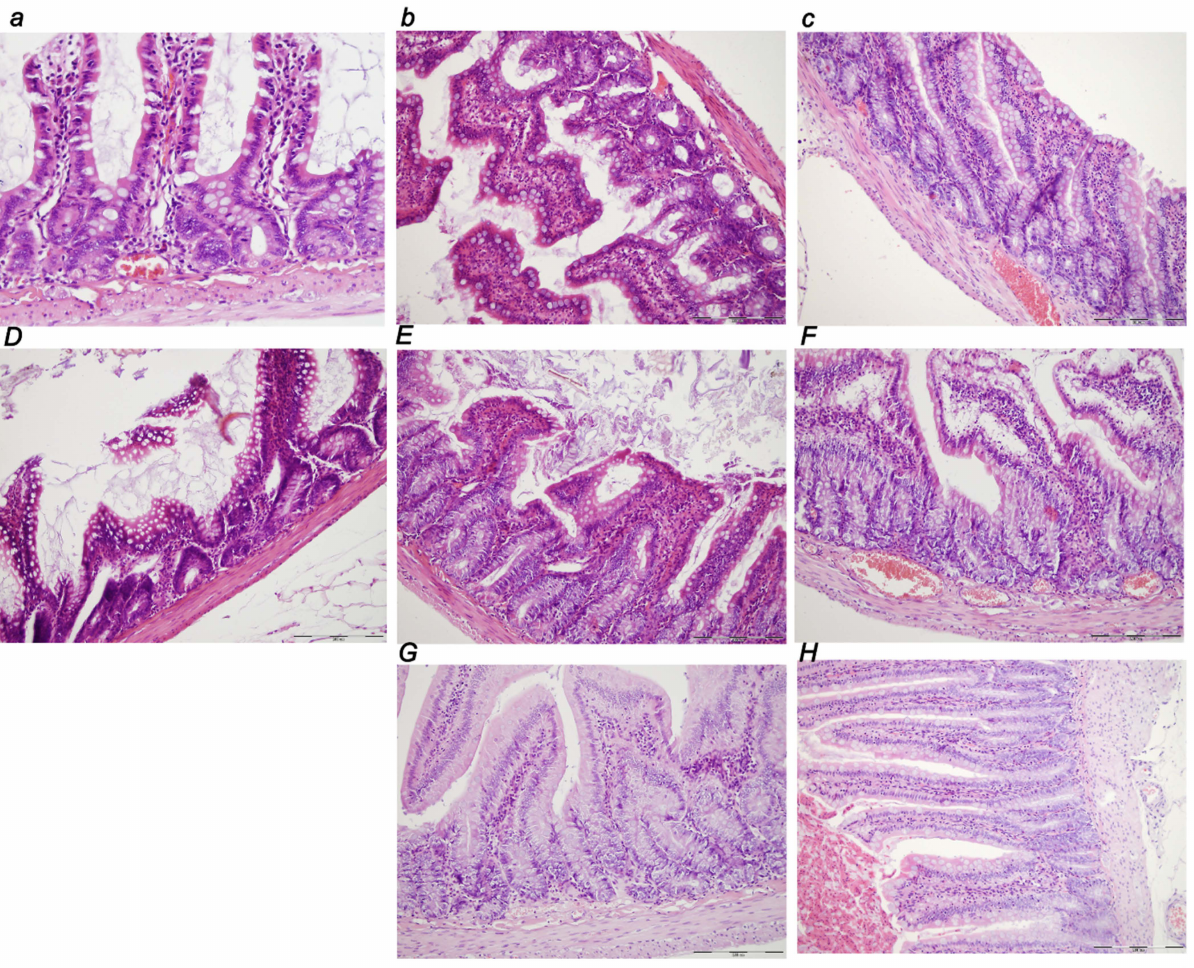
at 30 min ( a ), 5 h ( b ), and 24 h ( c ) ligation time was observed, along with hemorrhagic erosions (black arrow) and intramucosal neutrophilic inflammatory infiltration (rectangular marked area; magnification 400 × ; scale bar 50 µ m) noted at 5 h and 24 h. In the BPC 157 early regimen ( D – F ), no changes appeared at 30 min ( D ), 5 h ( E ) and 24 h ( F ) ligation time. In the delayed regimen ( G , H ), no changes appeared at 4.30 h–5 h ( G ) while only mild congestion appeared at 5 h–24 h ( H ) application sacrifice period. Small Intestine In the small intestine, there was marked congestion at 30 min, 5 h, and 24 h of ligation time, being more prominent at 24 h. The BPC 157 early regimen showed no changes at 30 min, and 5 h, and only mild congestion at 24 h of ligation time. The delayed regimen showed no change at 4.30 h–5 h, and only mild congestion at 5 h–24 h of the application sacrifice period (Figure 12).